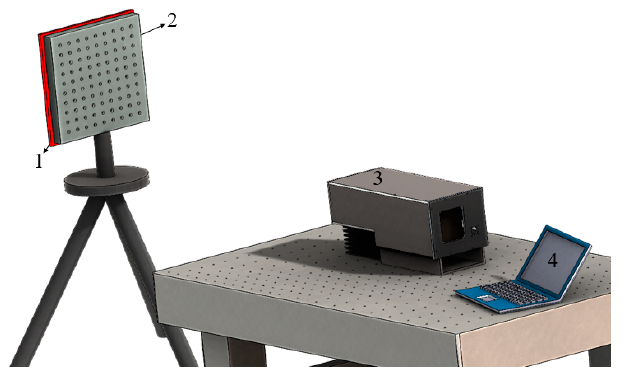
Figure 10. Schematic diagram of mid-infrared AOTF spectral imaging experiment for geometric calibration. 1—heating plate; 2—geometric calibration target; 3—AOTF spectrometer; 4—computer.